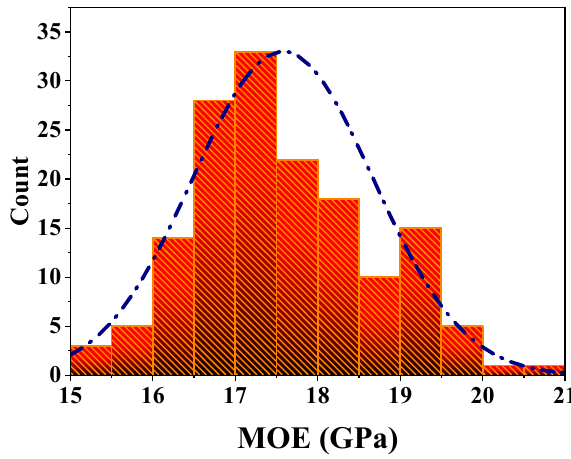
Figure 3. Distribution of MOE